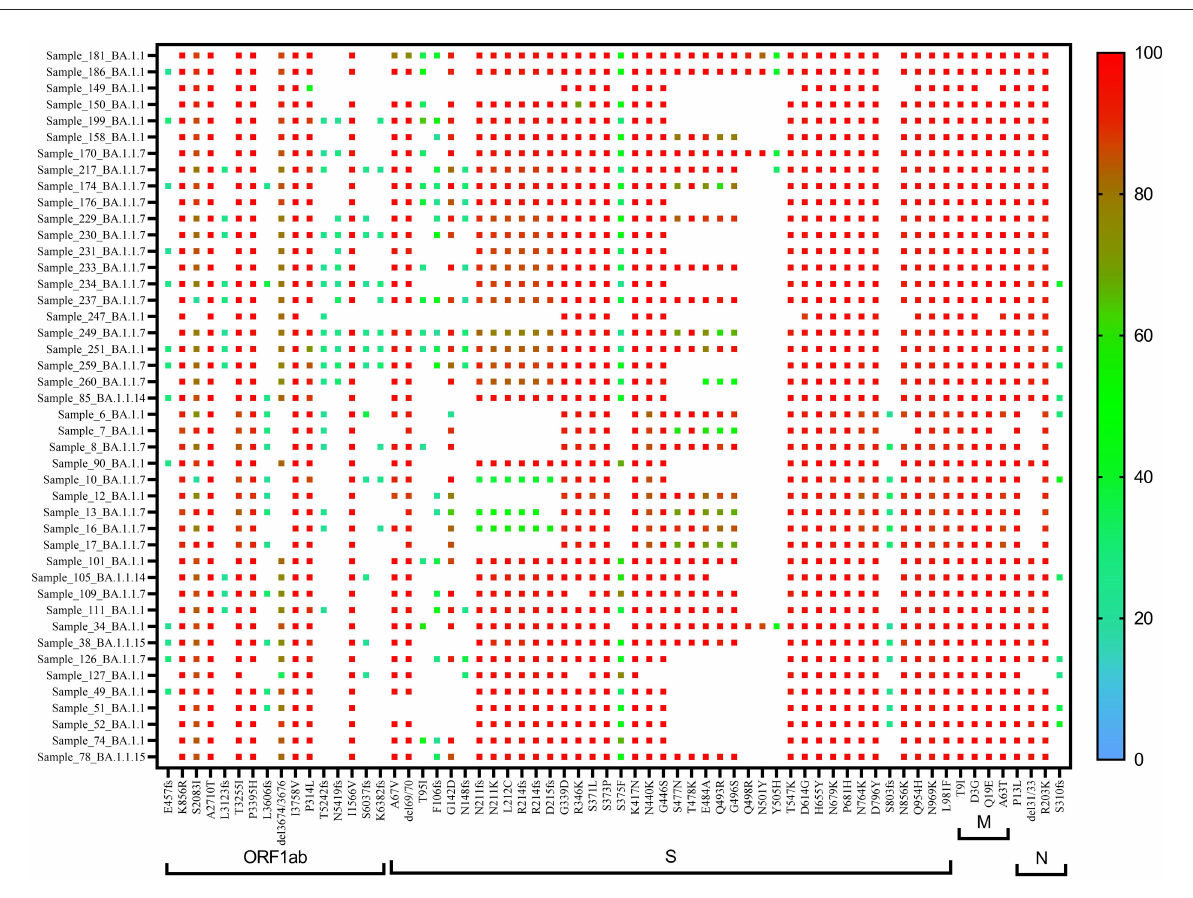
FIGURE5 Heat map of Omicron (BA.1.1)